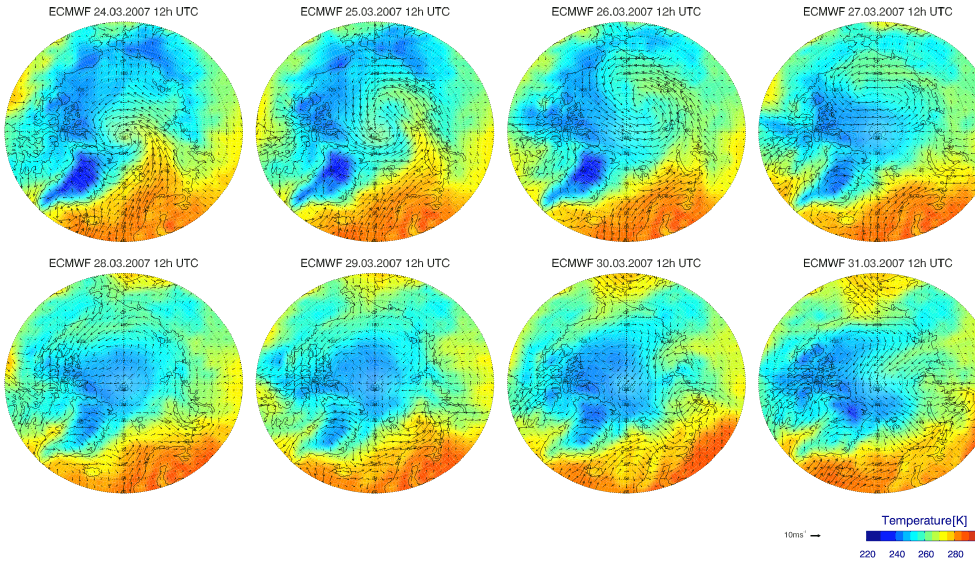
Fig. 2. ECMWF data, showing surface temperatures and wind fields during the BrO event (12:00hUTC).